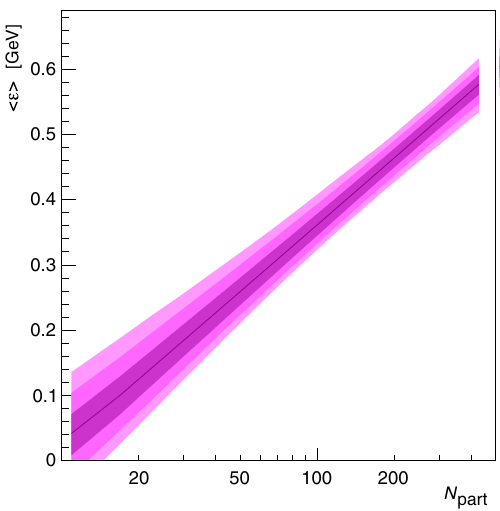
Fig. 6 Fitted average energy shift (cid:4) (cid:8) (cid:5) as a function of N part